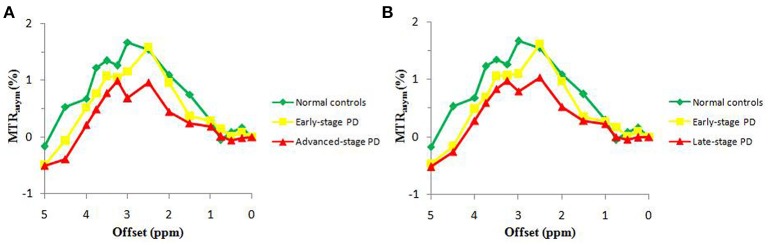
The average MTRasym spectra of the substantia nigra for three groups, based on the classification of H&Y scale (A) and based on the classification of disease duration (B).